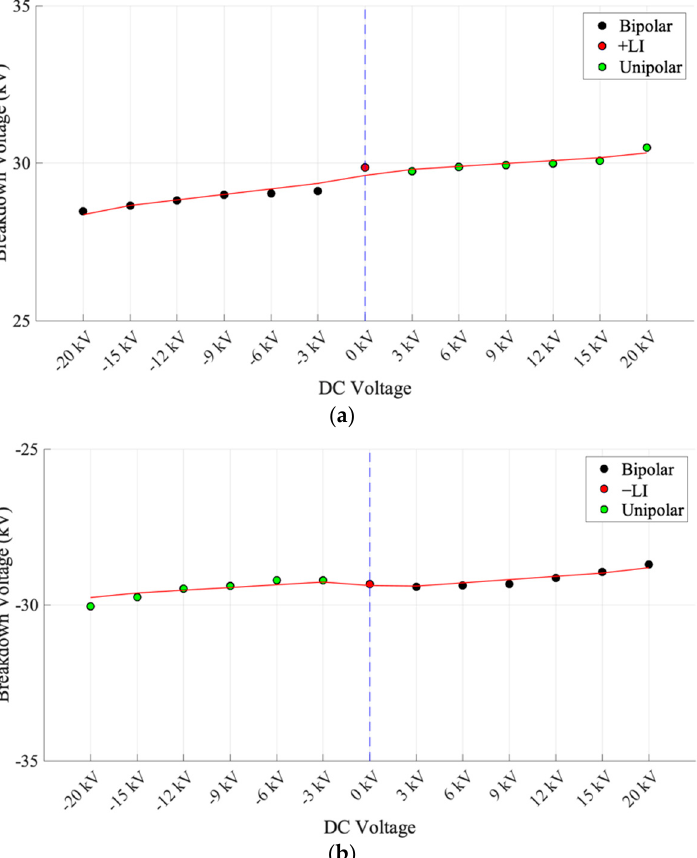
Figure 13. Variation of 50% breakdown voltage in less uniform electric field according to different +DC and − DC values: ( a ) +LI; ( b ) − LI.